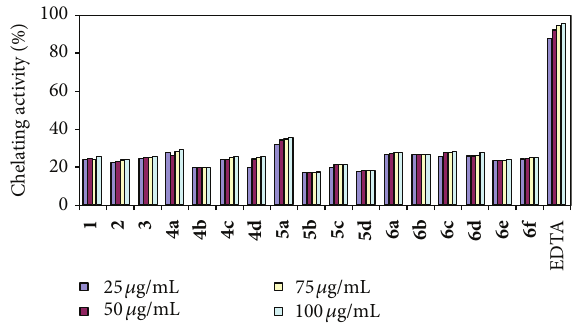
Figure 5: Metal chelating activity of new compounds.